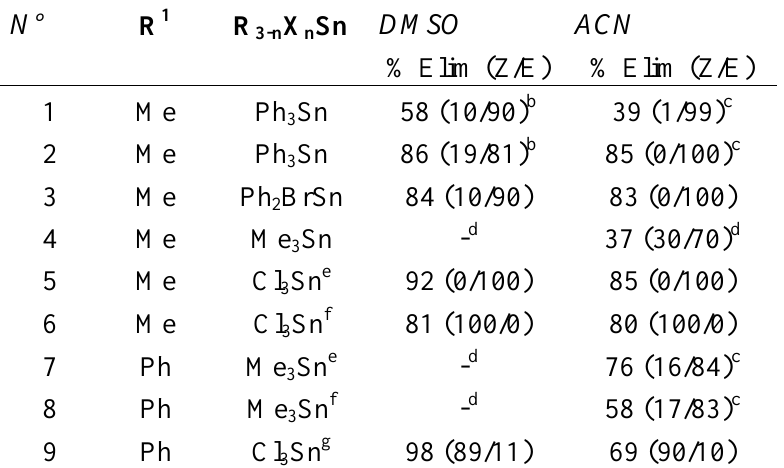
X Sn-CH(Ph)-CH(R 1 )-COPh with t BuONa a 3-n n